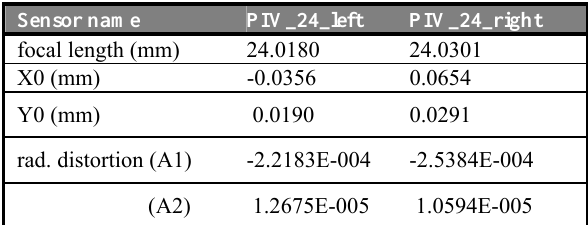
Table 1. Parameters of interior orientation obtained from testfield calibration